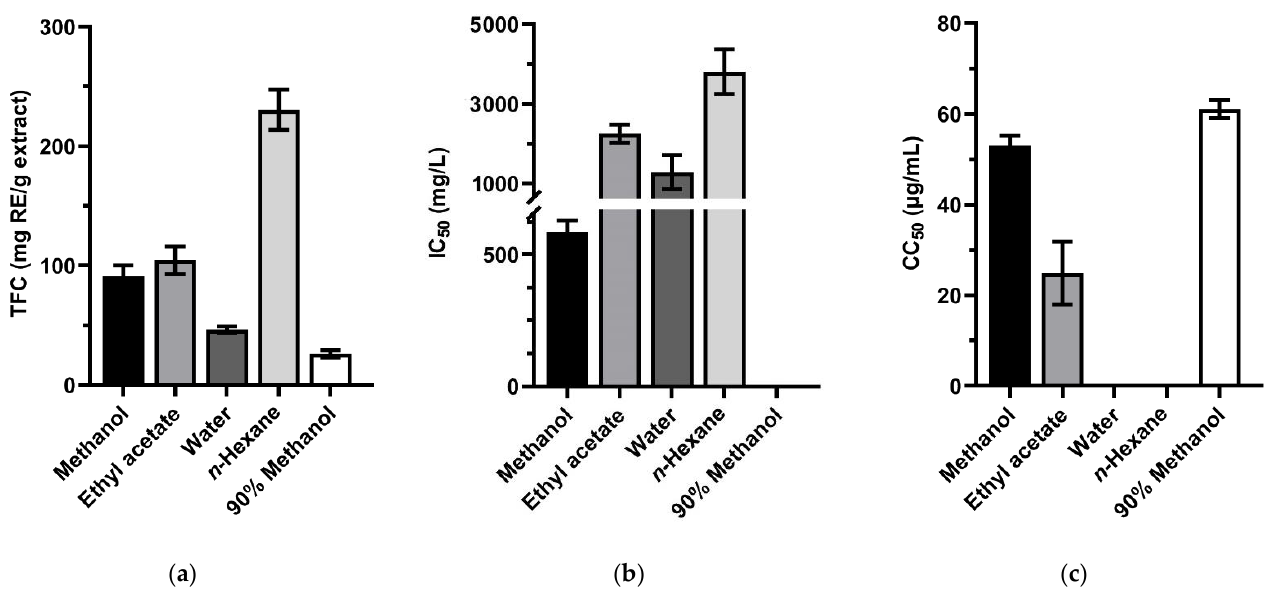
Figure 4. ( a ) Total flavonoids content, ( b ) the antioxidant activity in DPPH assay and ( c ) the cytotoxicity effect on Huh-7 HCC cells of Solanum torvum leaves extracting in methanol, ethyl acetate, water, n -hexane, and 90% methanol. For panel ( b ), the 90% methanol bar is unseen because the extract did not exhibit the antioxidant capacity. No bar in panel ( c ) is shown for the extract that had a 50% cytotoxic concentration of more than 100 µg/mL. Values are presented as mean ± SD ( n = 3). Error bars show standard deviation.